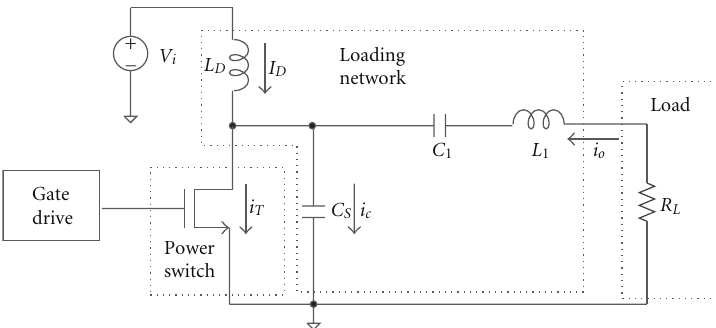
Figure 2: Schematic of a typical class E power amplifier.